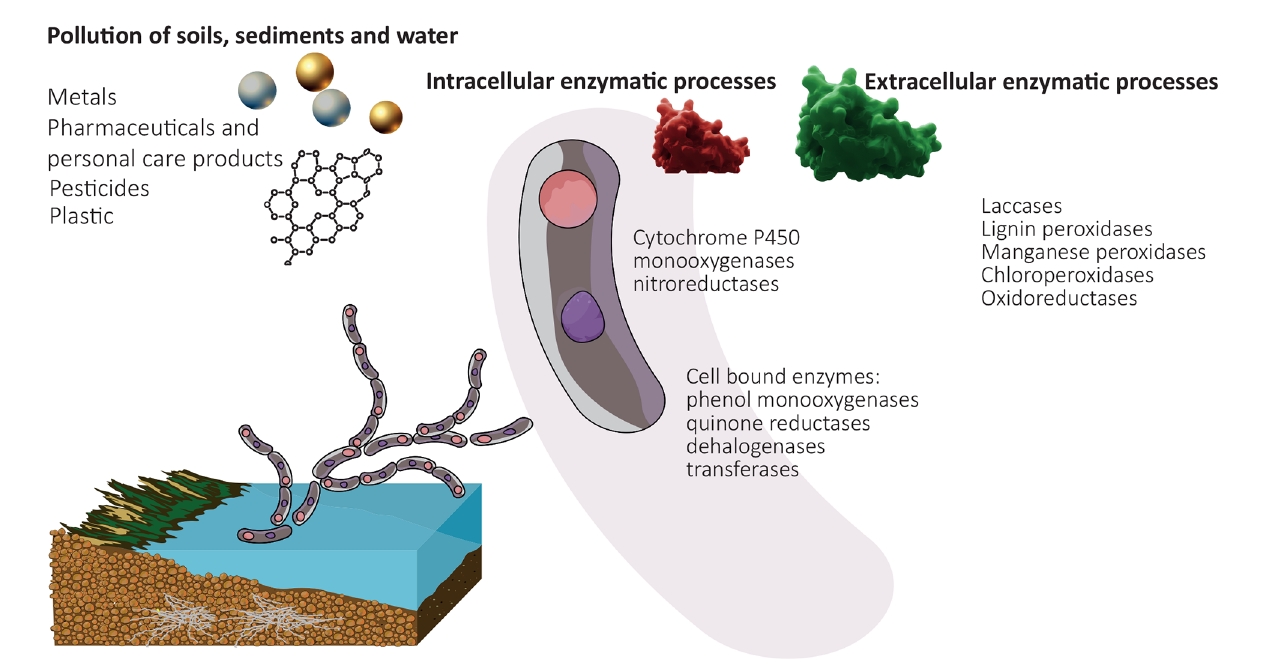
FIGURE 1 Schematic overview of mycoremediation in the environments. Pollutants and commonly used fungal enzyme classes are highlighted. Pollutants follow intracellular and/or extracellular enzymatic degradation, leading to the production of a diversity of metabolites and/or degradation